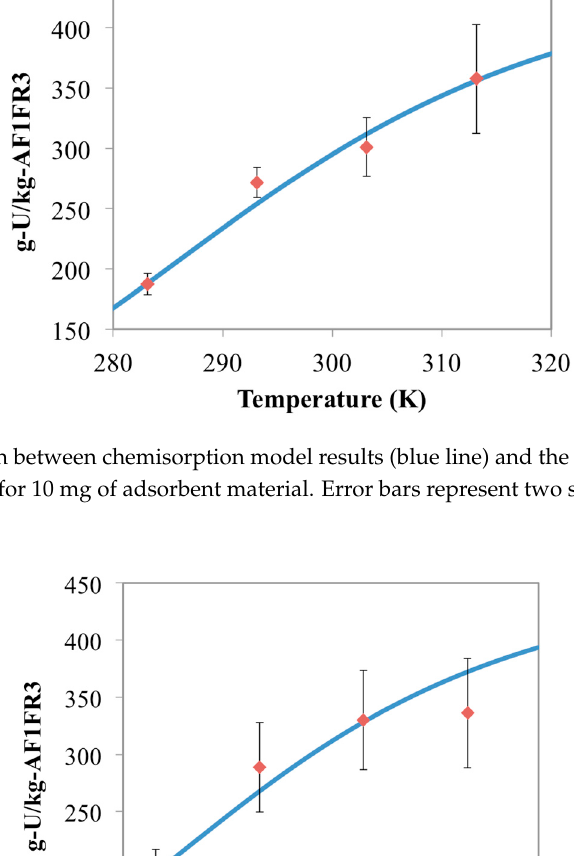
Figure 3. Comparison between chemisorption model results (blue line) and the AF1FR3 experimental data (red diamonds) for 15 mg of material. Error bars represent two standard deviations of the data.